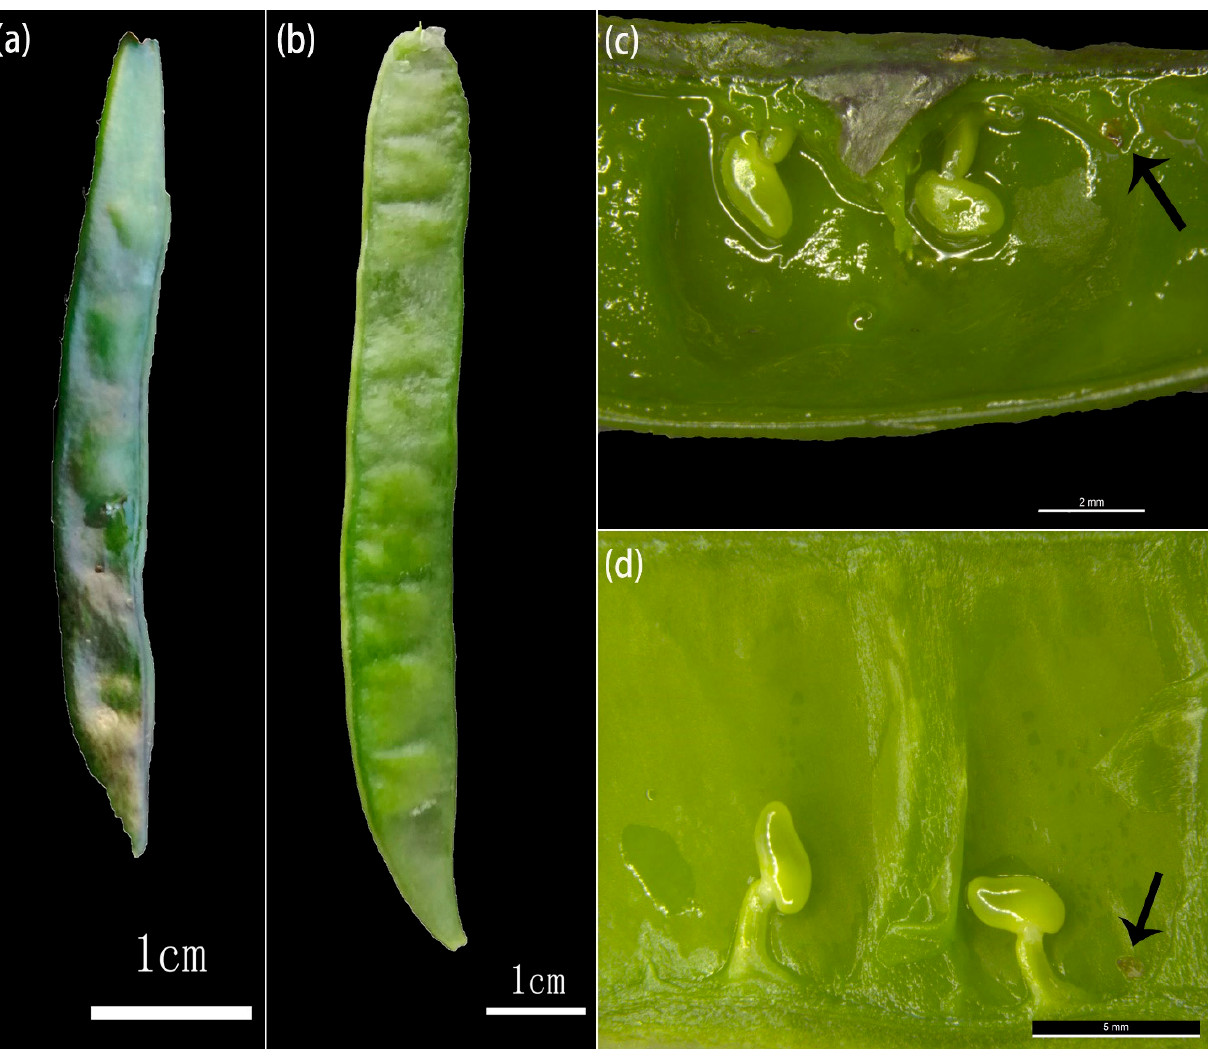
Figure 3. Ovaries and immature zygotic embryos at 30 days after pollination in ( a , c ) 2016 and ( b , d ) 2017.